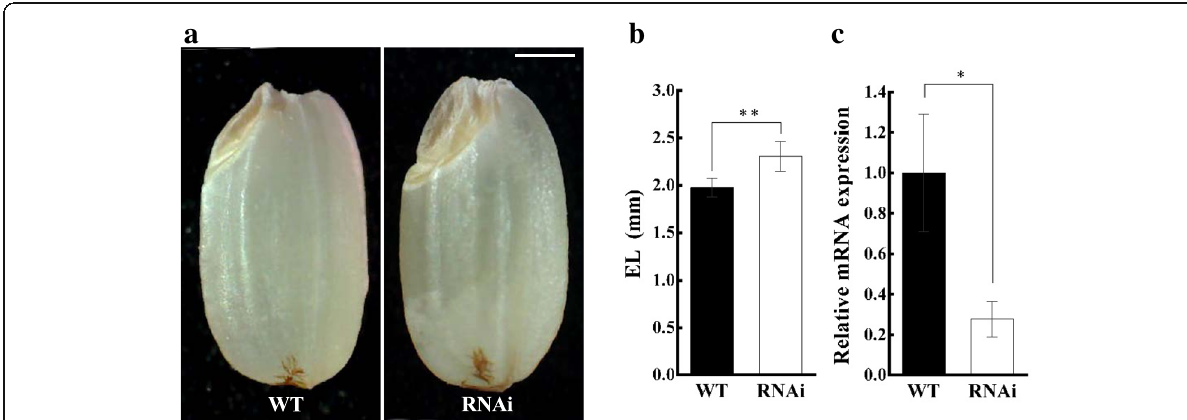
Fig. 5 Comparison of embryo phenotype and LE expression between RNAi transgenic plant and wild type (Dongjin). a Seed phenotype of WT and RNAi plants. b Comparison of embryo length between WT and RNAi plants. c Relative expression of LE (normalized to UBIQUITIN ) in WT and RNAi plants. Error bars indicate ± s.d. of three replicates. Asterisks represent significant difference, as determined by a two-tailed Student ’ s t -test (*, p < 0.05; **, p < 0.01). Scale bar = 1 mm